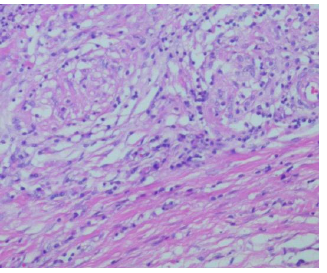
FIGURE 2. Nephrectomy specimen showing chronic interstitial nephritis. Hematoxylin-eosin stain, original magnification × 100.